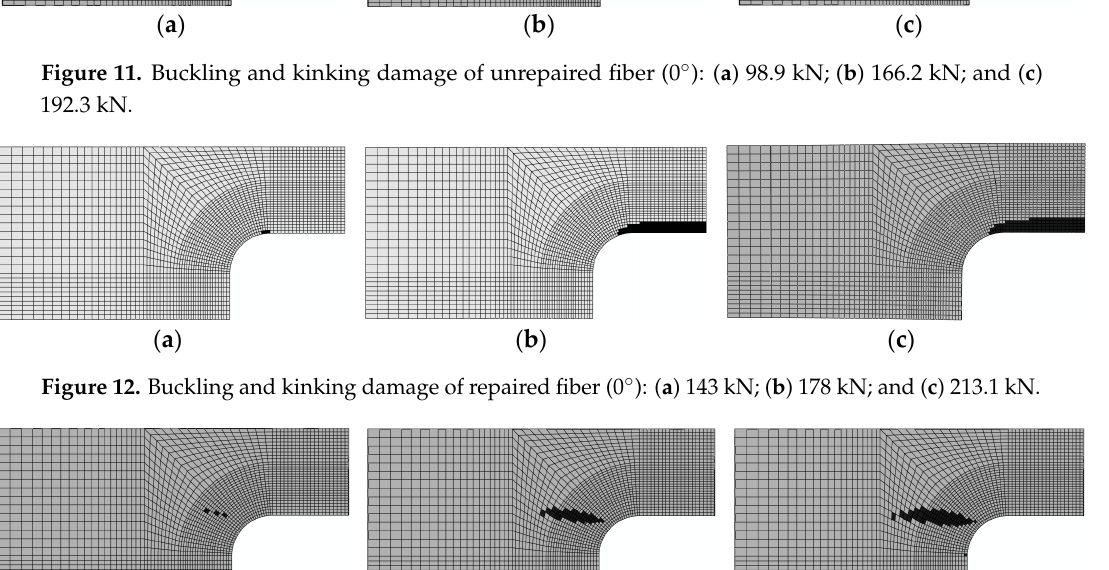
Figure 11. Buckling and kinking damage of unrepaired fiber (0°): ( a ) 98.9 kN; ( b ) 166.2 kN; and ( c ) 192.3 kN.